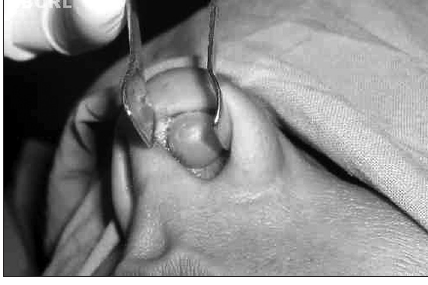
Figure 1. Showing a smooth cystic swelling of approximate size 1.5 x 1.0 cm on the left side of the membranous nasal